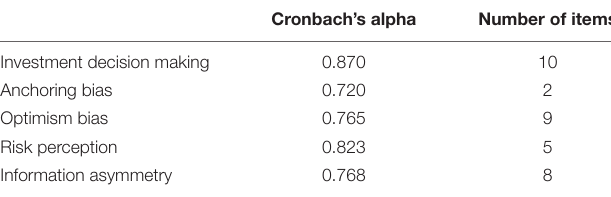
TABLE 2 | Reliability